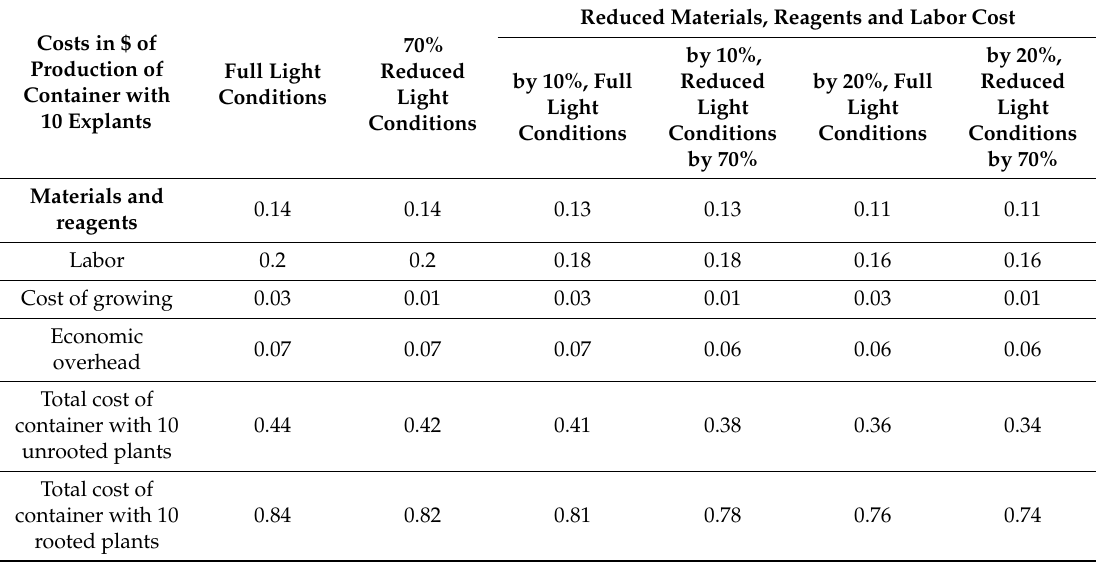
Table 5. Analysis of costs with the two highest costs, materials, reagents and labor, of in vitro